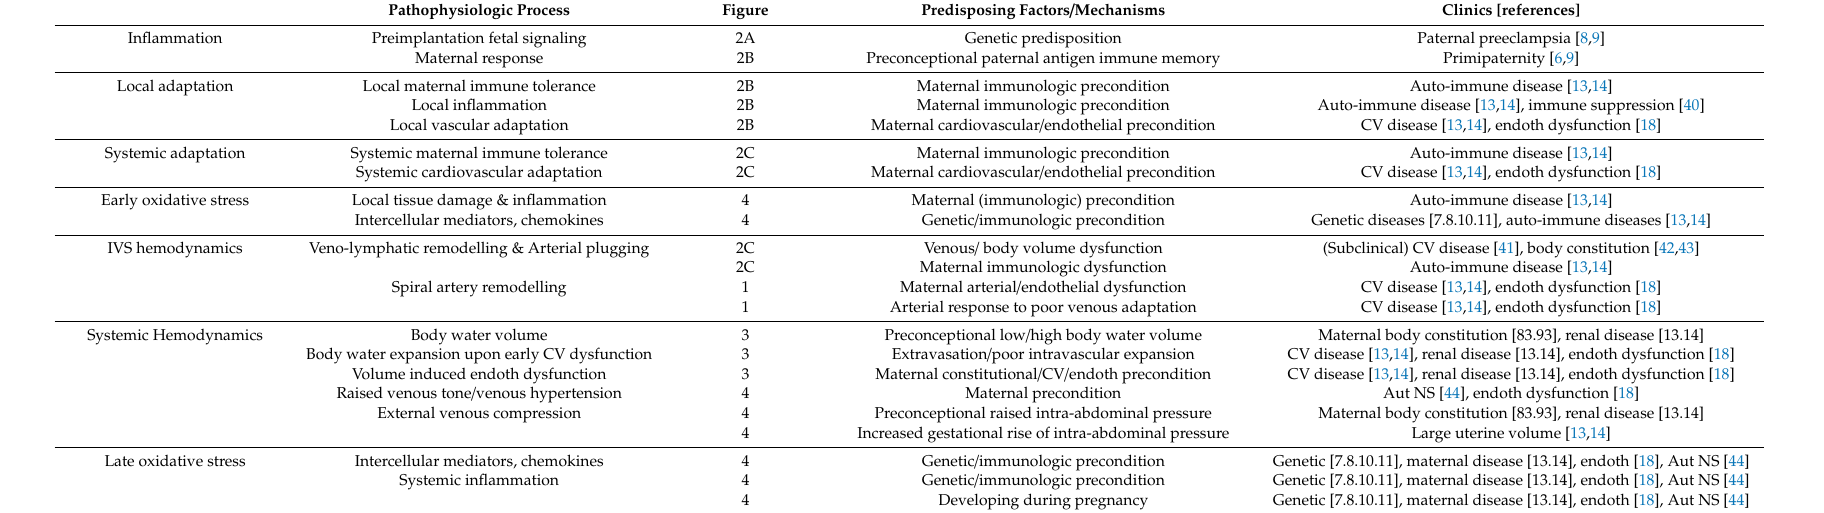
Table 2. Consecutive sequence of pathophysiologic events associated with